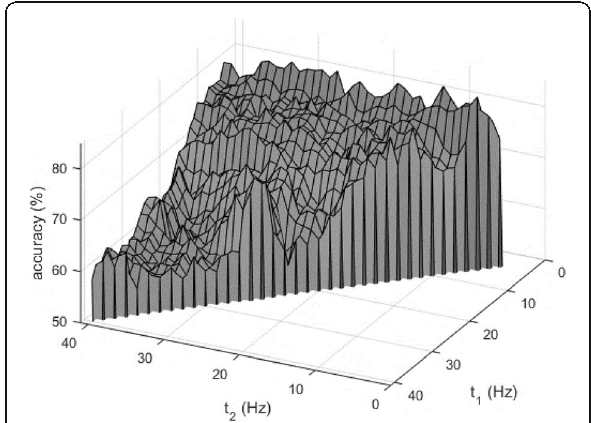
Fig. 7 Obtained accuracy for N = 2 ( t 1 = 2:38 Hz, t 2 = 4:40